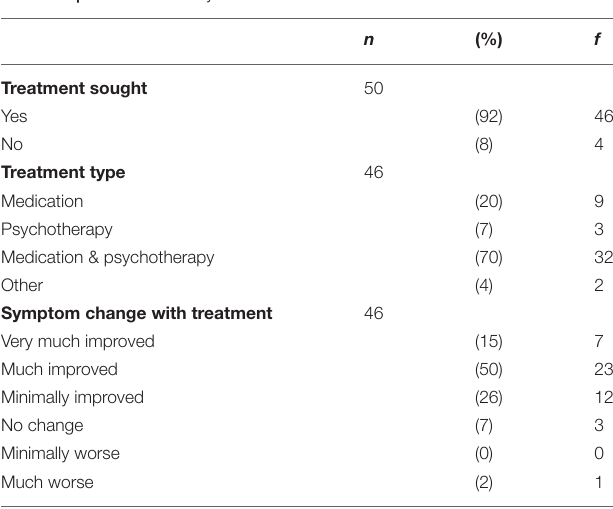
TABLE 1 | Treatment